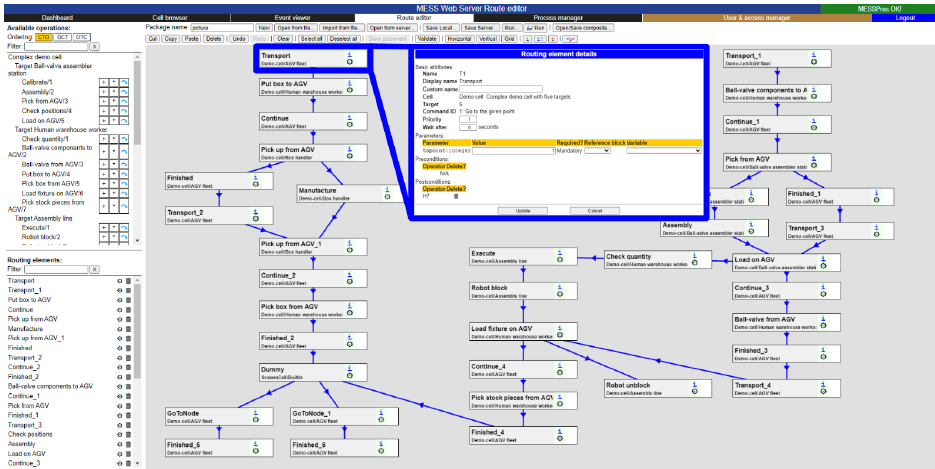
Figure 11. Process plan of the demonstrated use-case